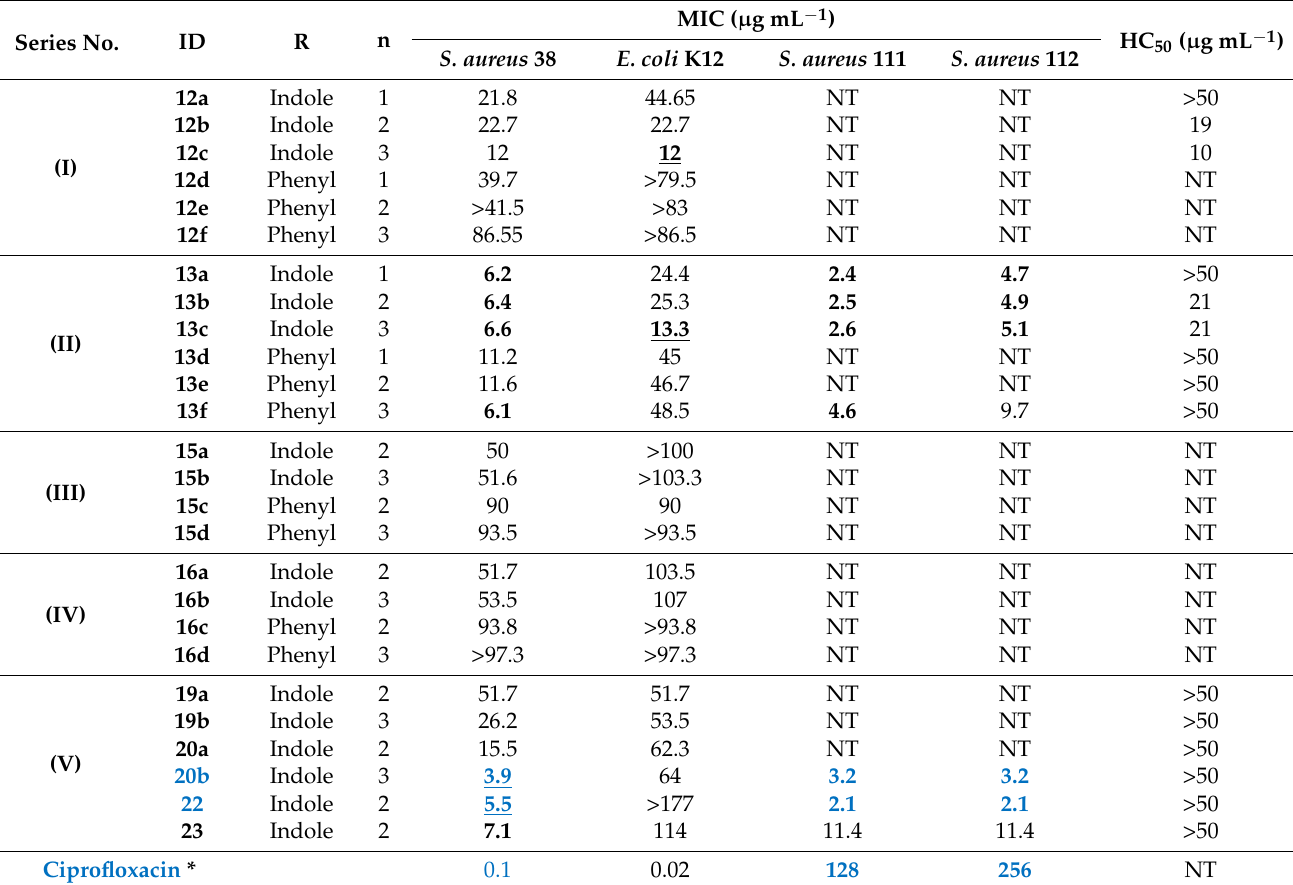
Table 1. Antibacterial activity (MIC) and hemolytic activity of the